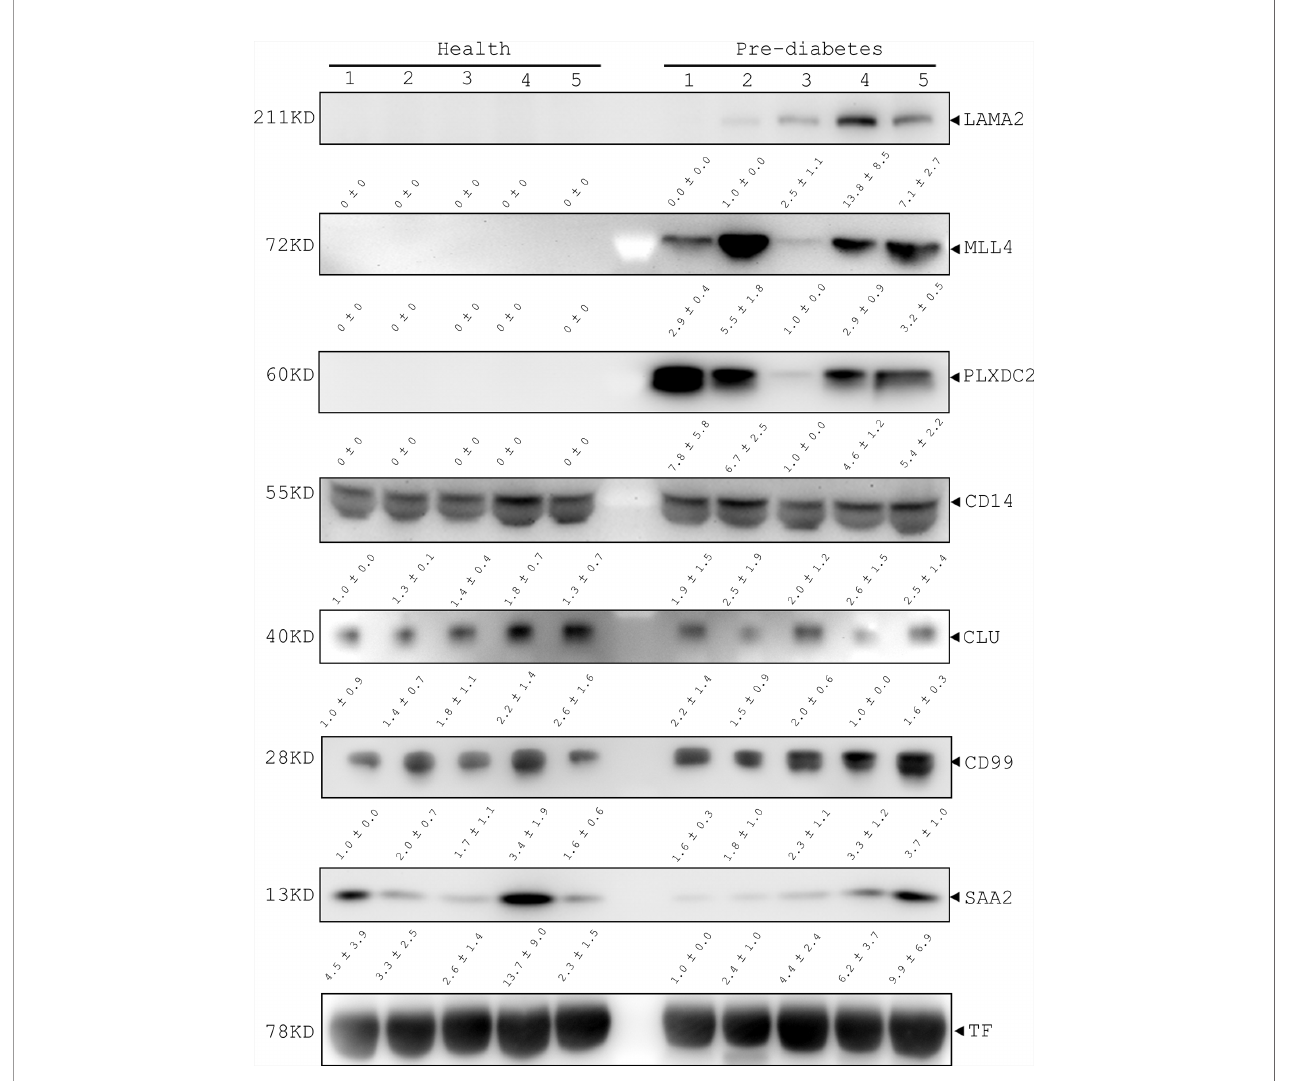
FIGURE 4 | Immunoblotting analysis of LAMA2, MLL4, PLXDC2, CD14, CLU, CD99, and SAA2 in healthy and pre-diabetic sera of human origin. Serum samples of healthy and pre-diabetic subjects were collected and then lysed with lysis buffer. After centrifugation, total lysates were prepared for immunoblotting analysis with the antibodies as indicated. Transferrin (TF) was used as an internal control of human